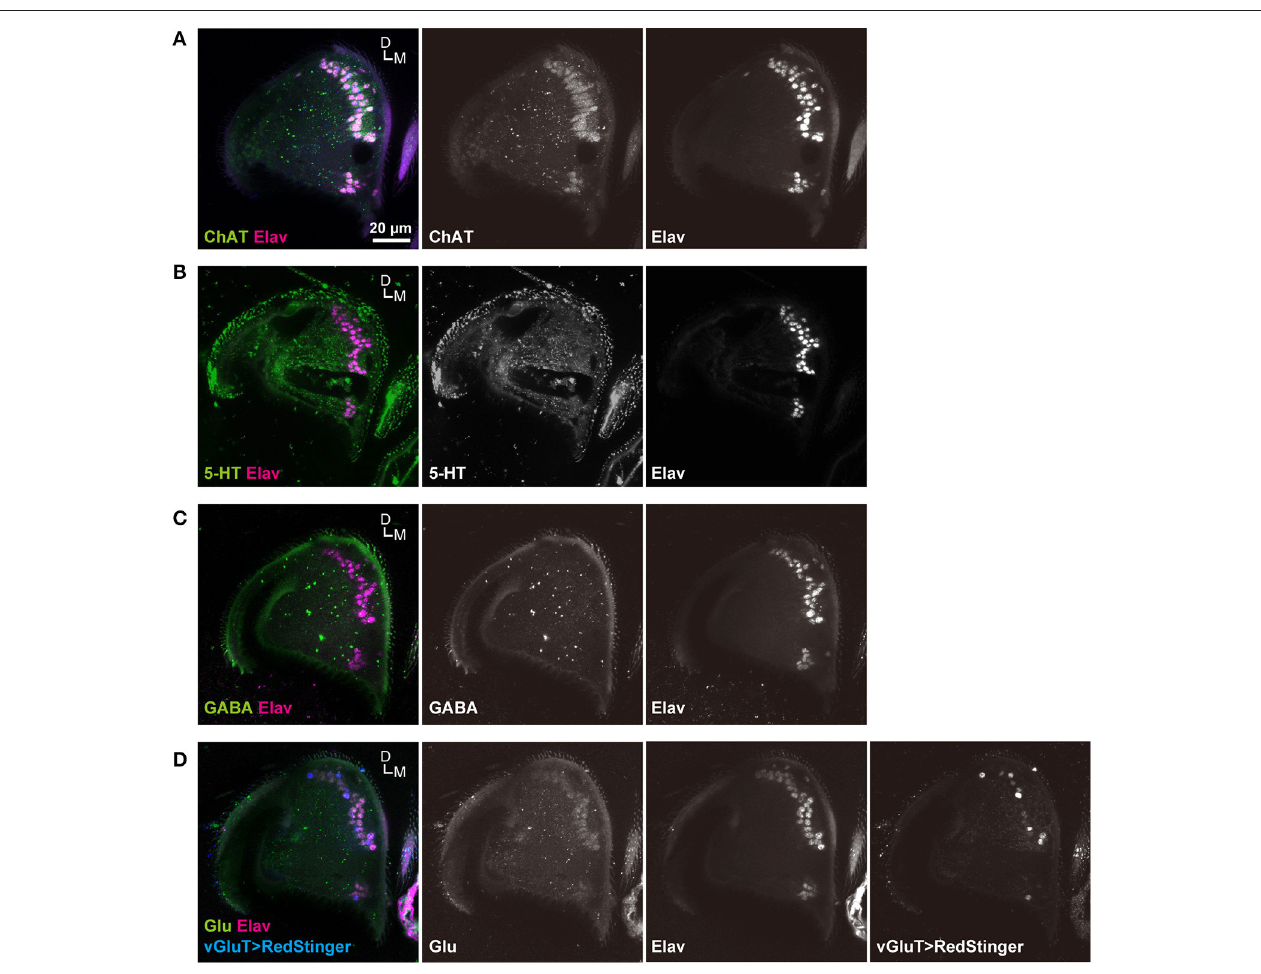
FIGURE 6 | Neurotransmitter of JO neurons. JO neurons labeled with anti-ChAT (A) , anti-serotonin (5-HT) (B) , anti-GABA (C) , and anti-glutamate (Glu) (D) antibodies (green signals). The nuclei of all JO neurons were labeled with anti-ELAV antibody (magenta signals). vGluT positive neurons were labeled by a combination of vGluT-GAL4 driver and UAS-RedStinger marker strains (blue signals) (D) . D, dorsal; M,